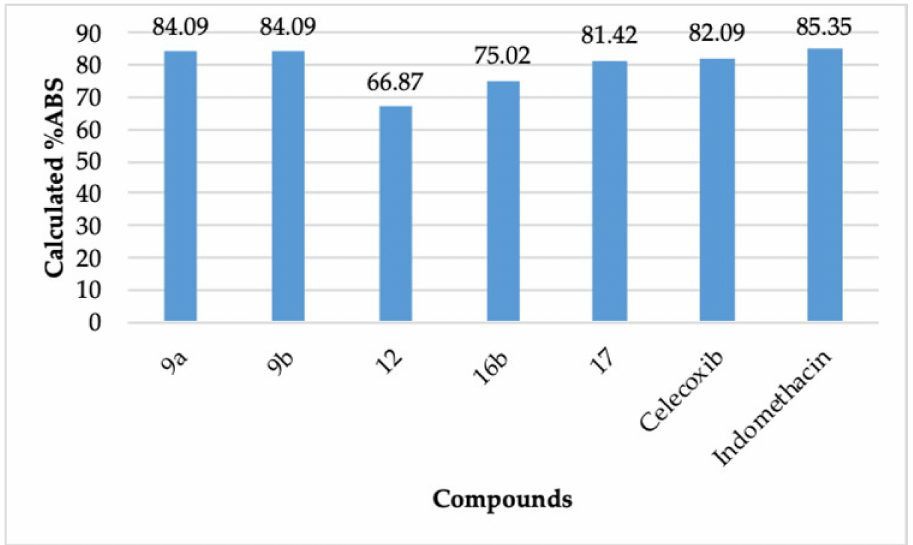
Figure 4. Calculated degree of absorption (%ABS) of 9a , 9b , 12 , 16b , 17 , celecoxib, and